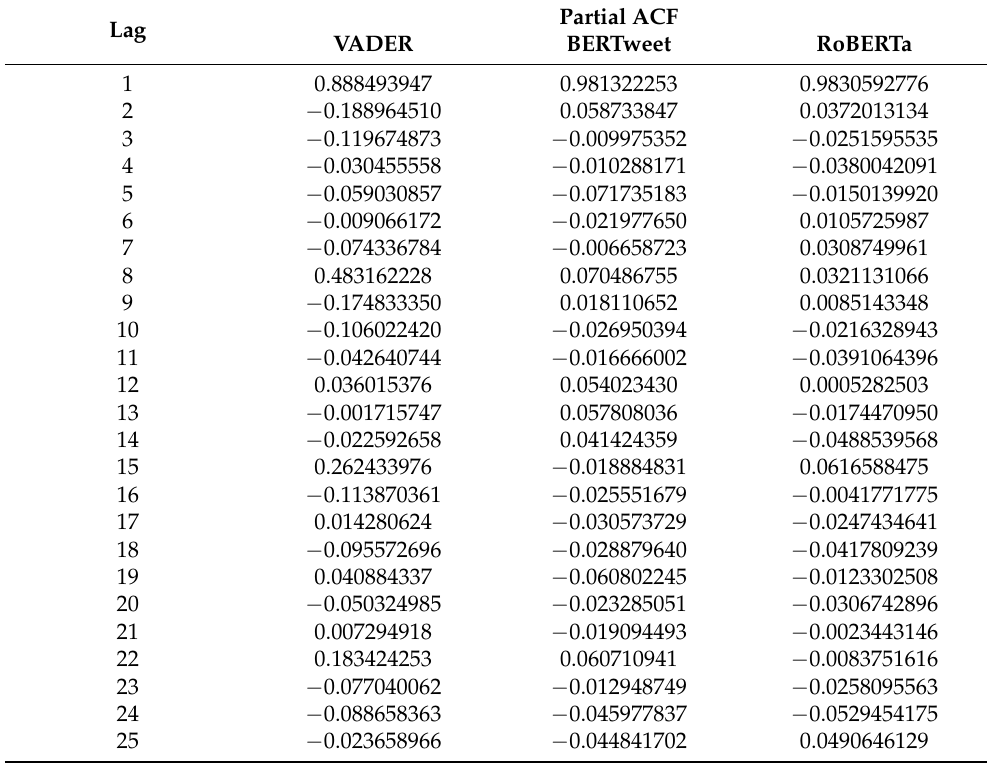
Table A1. Partial ACF (auto correlation function) of the sentiment polarity time series. Lag